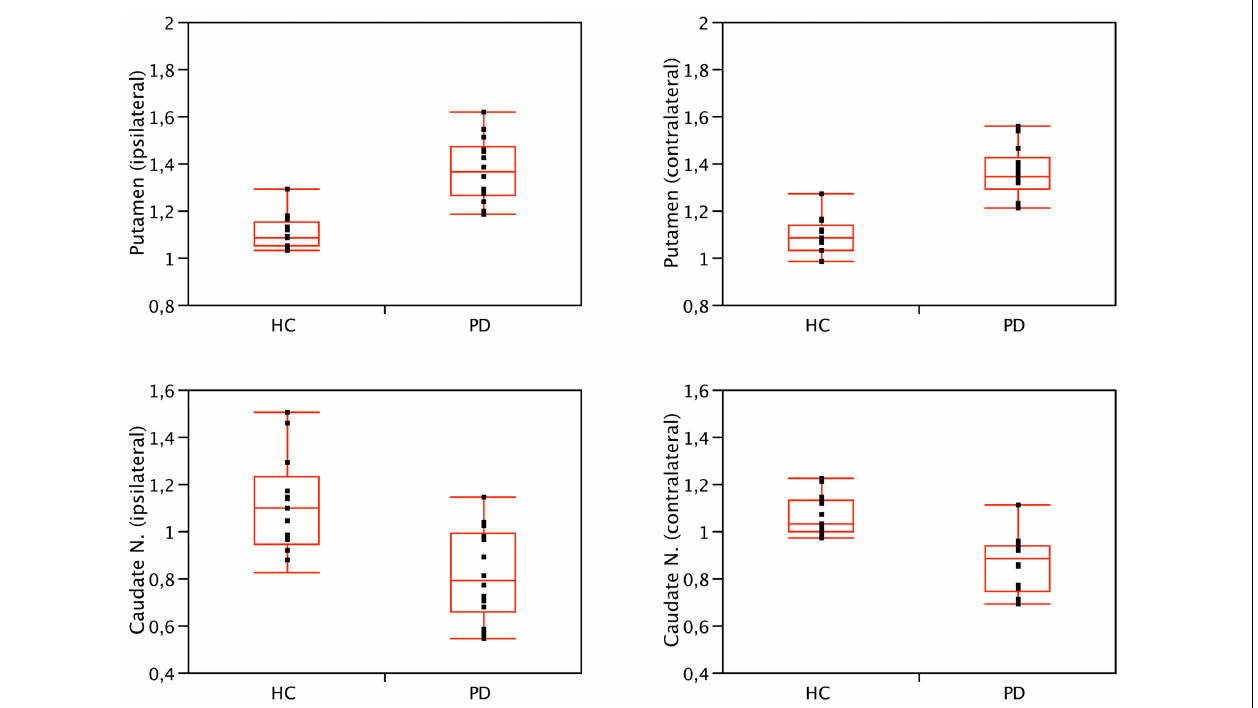
test). No significant difference was found when comparing ipsilateral and contralateral (or left and right) side, both in patients and controls. Contralateral refers to the side opposite to the clinically most affected hemibody. Right is conventionally contralateral for